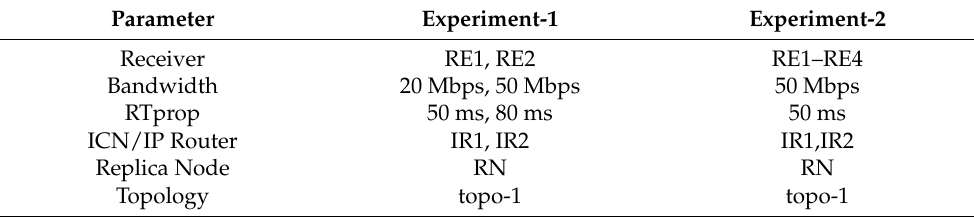
Table 2. NDC transmission process convergence experiment parameter settings. Parameter Experiment-1 Experiment-2 RE1,